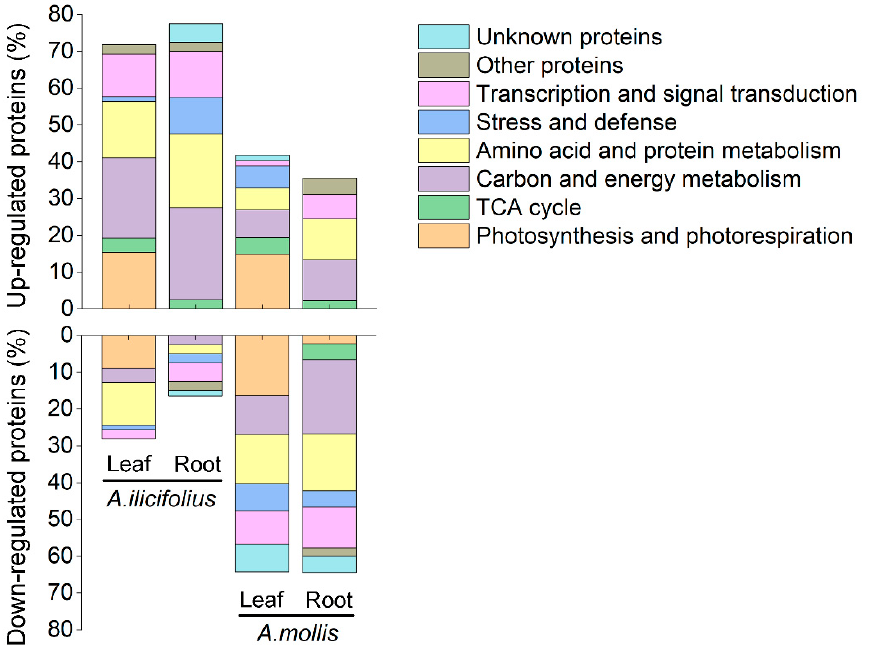
Figure 5. Functional classification analysis of the differentially expressed proteins (DEPs) of A. ilicifolius and A. mollis . The detailed information for each spot is shown in Supplementary Tables